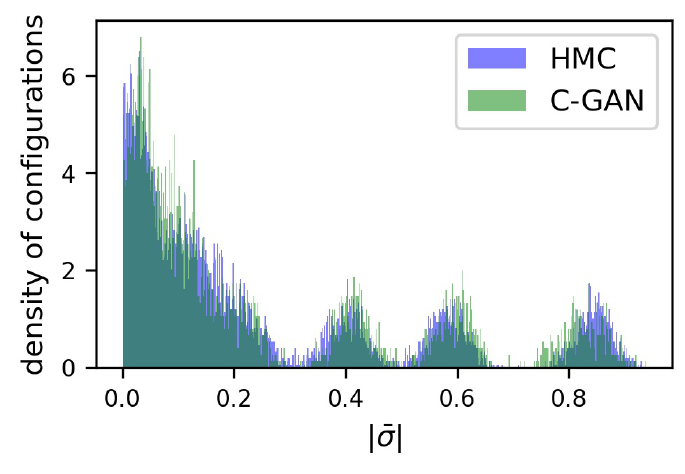
Figure 6: Histogram of | ¯ σ | for Λ